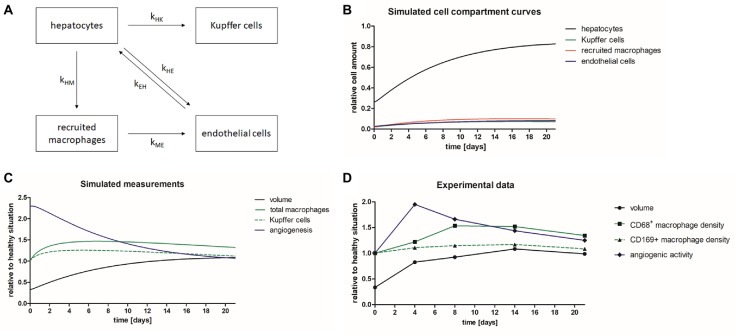
Mathematical model describing liver regeneration. A mathematical model has been developed describing liver regeneration at organ and tissue scale. (A) The scheme shows the interrelations between liver cell compartments (hepatocytes, Kupffer cells, recruited macrophages, and endothelial cells) during liver regeneration. (B) The simulated cell compartment curves show the normalization of relative cell amounts after PHx. (C) The simulated measurement curves were computed based on the simulated cell compartment curves. After iterative adjustment the simulated curves describing liver volume, total macrophages, Kupffer cells, and angiogenesis showed similar time courses as the experimental data. (D) Diagram showing the time courses for liver volume, CD68+ macrophage density, CD169+ macrophages, and angiogenic activity of the experimental data acquired in mice after PHx.